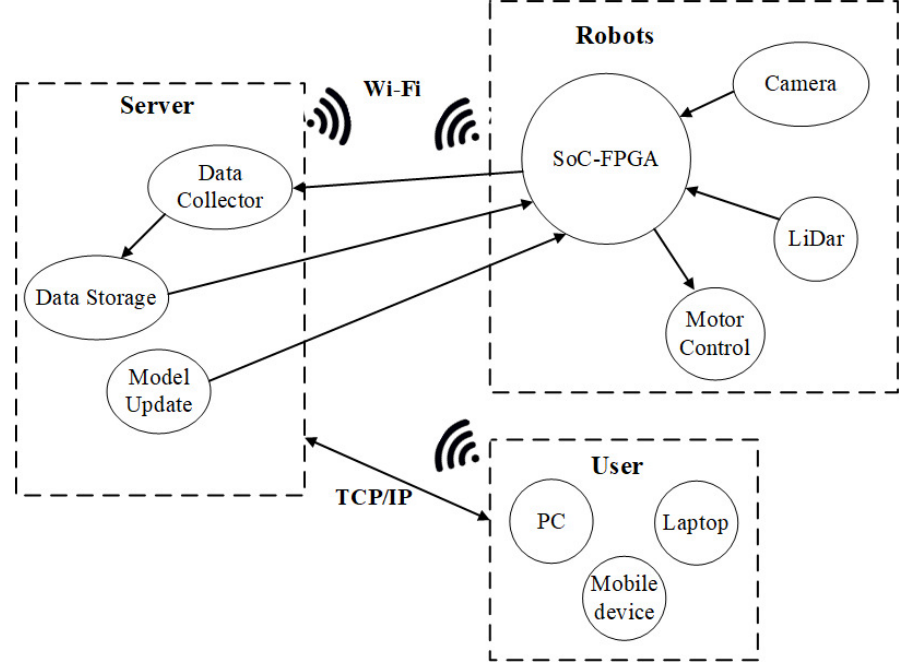
Figure 9. Distributed computation system for deploying real-time floor